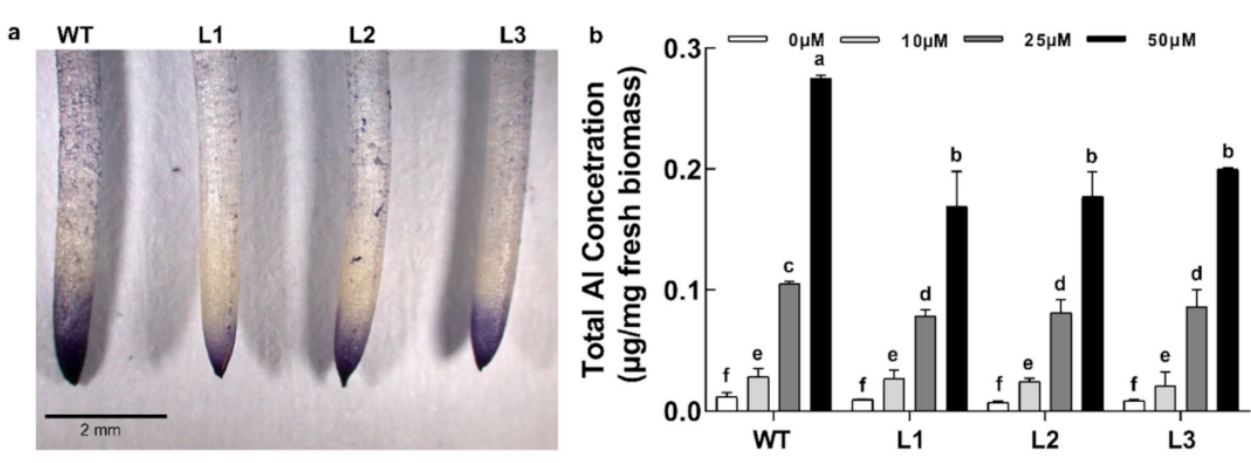
Figure 5. Analysis of Al accumulation patterns. ( a ) Al-treated (25 µ M AlCl 3 for 24 h) roots of WT and transgenic soybean lines were stained with hematoxylin, washed, and photographed. Bar = 2 mm. ( b ) The total Al accumulation in the roots. Soybean seedlings with consistent growth were transferred into a 0.5 µ M CaCl 2 hydroponic solution (pH 4.5) containing 0, 10, 25, or 50 µ M AlCl 3 for 24 h. The Al of the roots (0–6 cm) was extracted by 2N HCl and determined. The data are the means ± SDs ( n = 12). The different letters indicate significant differences at p < 0.05 as determined by Student’s t